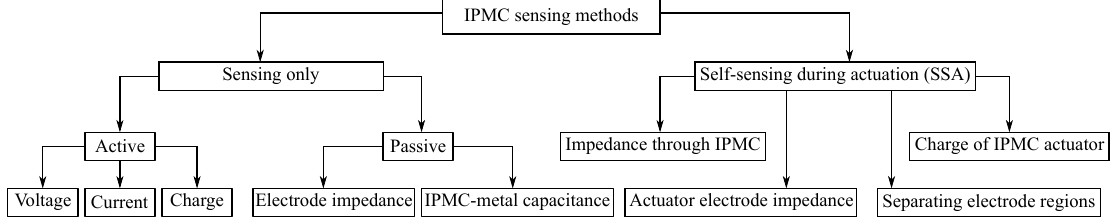
Figure 3. Classification of reported sensing and SSA methods for